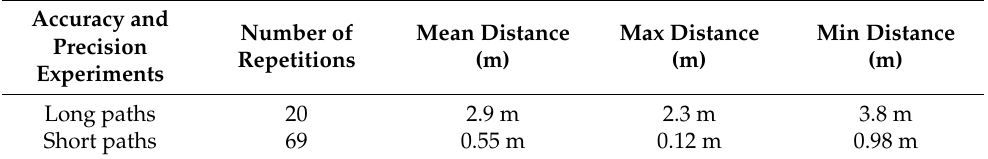
Table 1. Summary of accuracy and precision experiments.